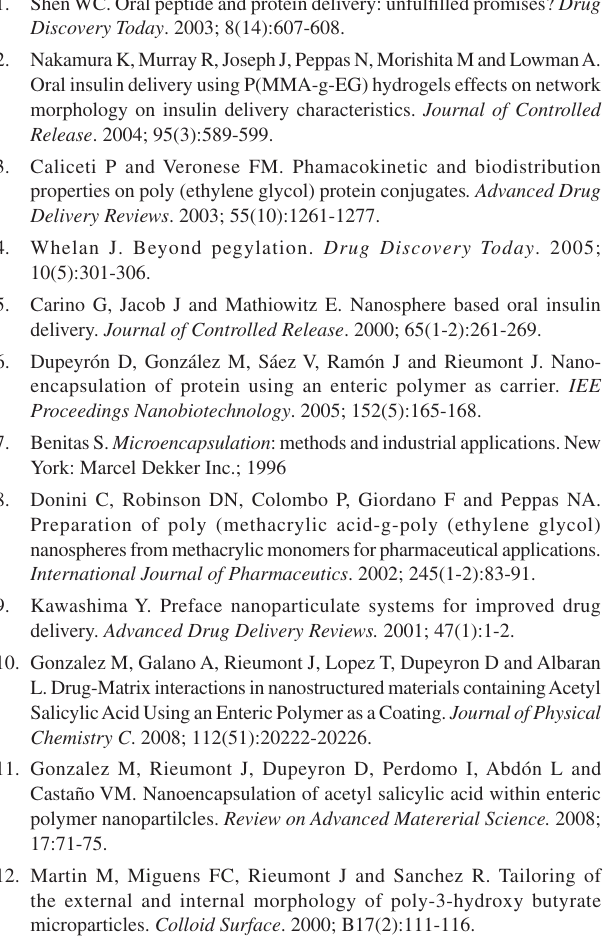
Figure 4. Results of Dynamic light Scattering of Sample B6. (NNLS)